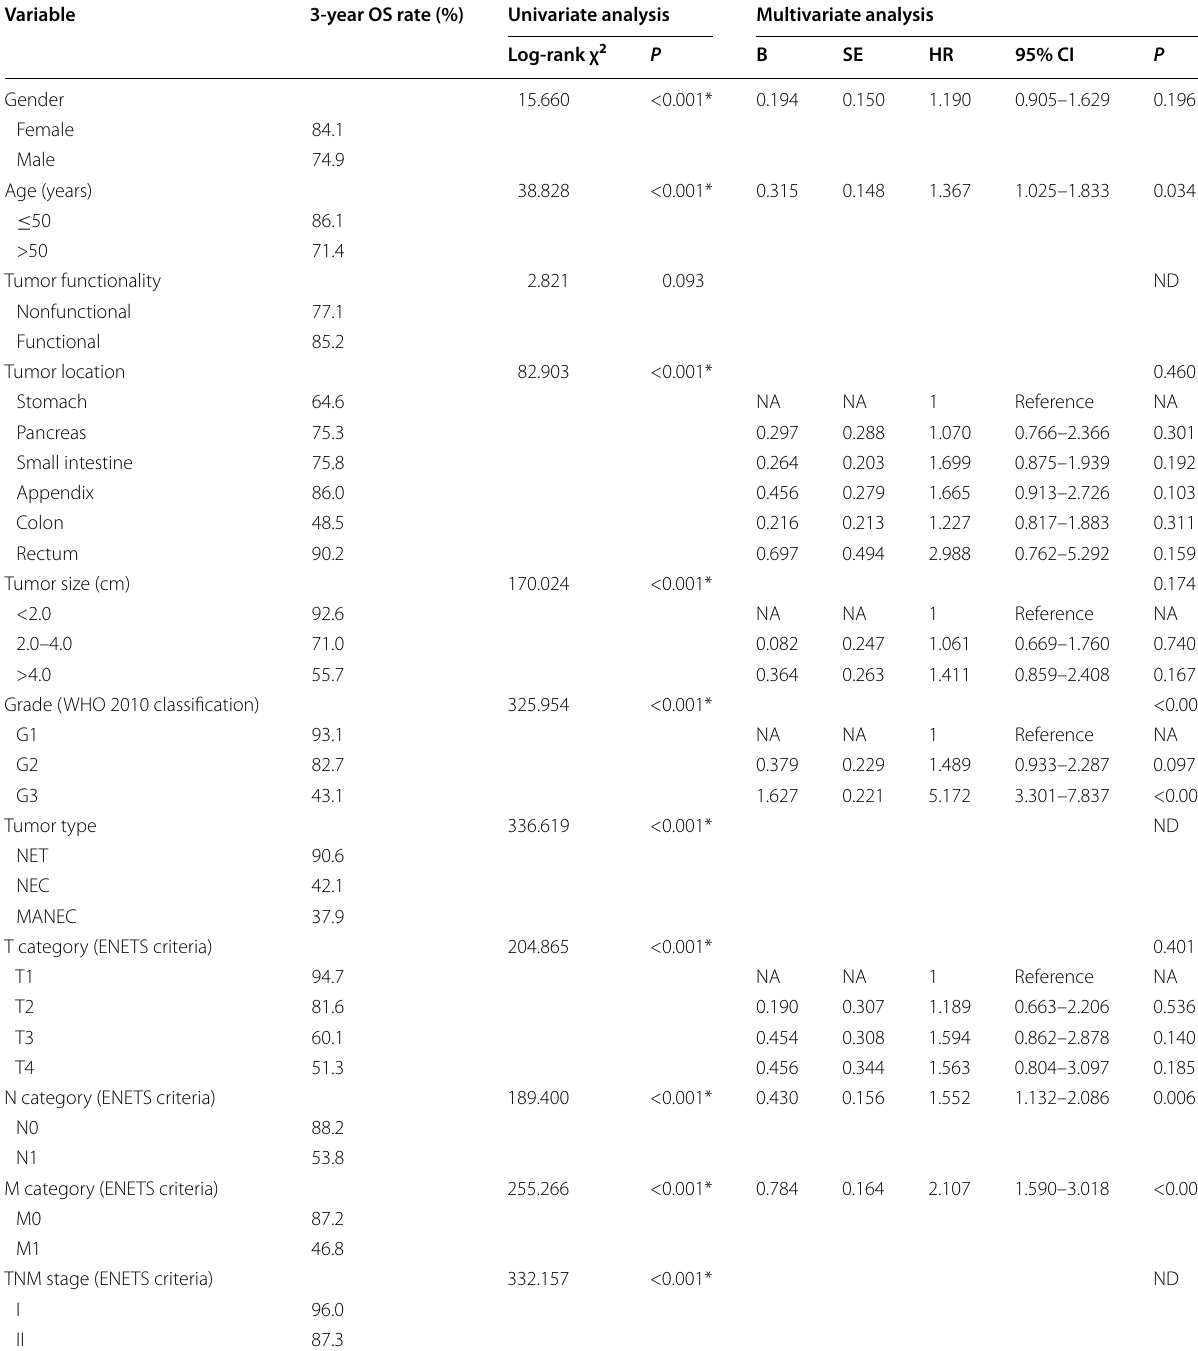
Table 3 Univariate and multivariate analyses of prognostic factors for overall survival of 1183 patients with